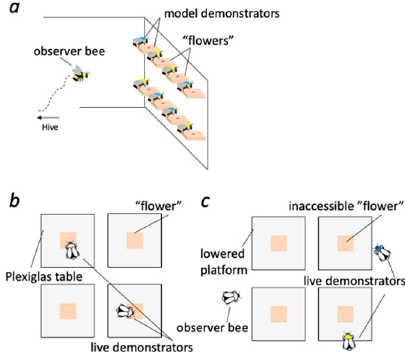
Figure 1. Schematic views of the arena during training and testing. ( a ) Observer bees were trained to find 50% sucrose solution on four of the eight flowers arranged on the far wall of the arena and aversive quinine solution on the other four flowers. Next to each of the flowers was placed one of two types of model demonstrator. Each model demonstrator’s thorax was painted blue or yellow. ( b ) Live demonstrators were trained to crawl underneath four Plexiglas platforms to obtain a reward on a flower. Trained individuals were then given either a blue or yellow paint mark on their thorax prior to testing the observer. ( c ) Observer bees were tested in a novel context featuring two live demonstrators. In this novel situation, the flowers were not accessible, and as a result, the live demonstrators searched the floor of the arena for reward.